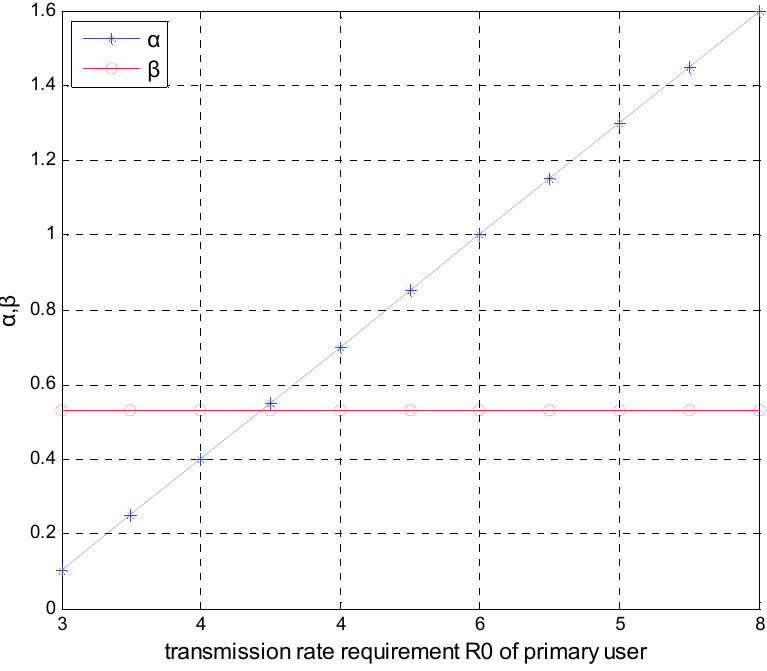
Figure 5. Optimal time allocation strategy α * and optimal bandwidth strategy β * versus the transmission rate R